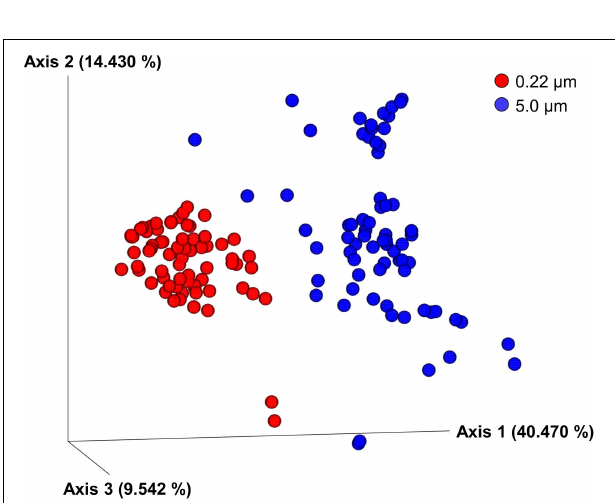
FIGURE 3 | Principal coordinate analysis (PCoA) of weighted Unifrac metrics of samples labeled according to filter pore size (i.e., 0.22- and 5.0- µ m filters). Differences among bacterial communities were significant according to PERMANOVA and ANOSIM tests ( q =